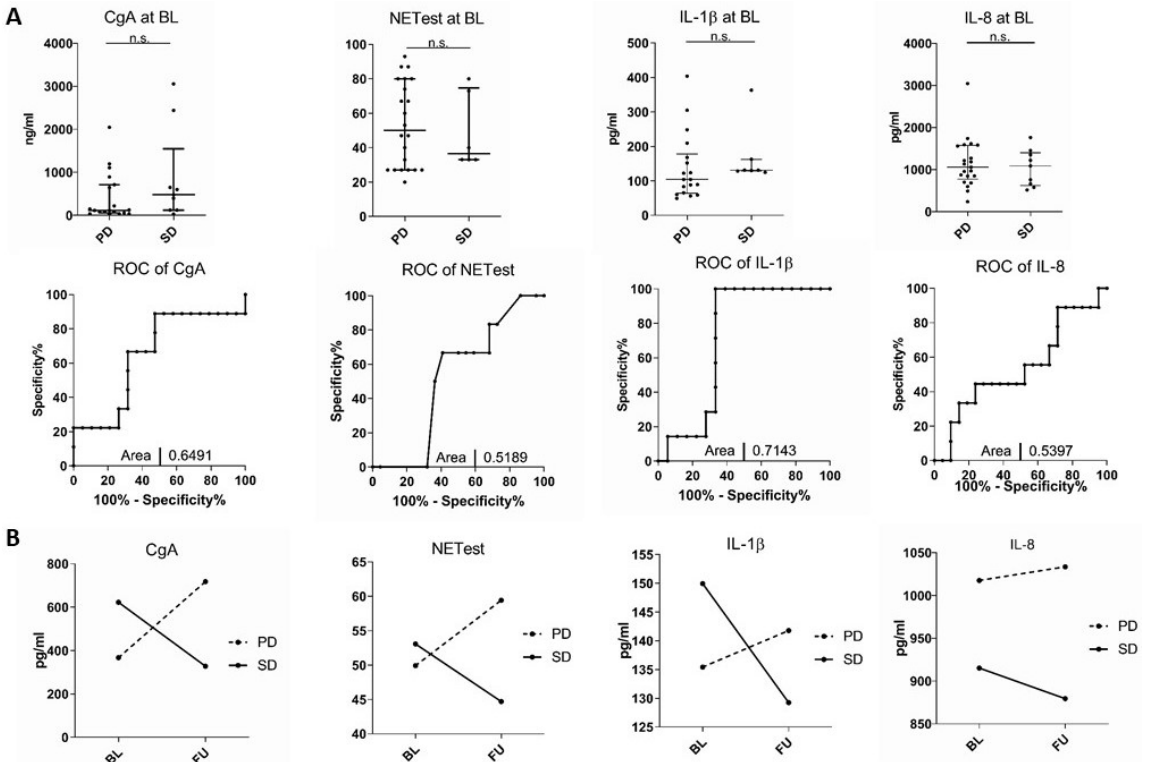
Figure 3. Serum cytokine levels at initial diagnosis may indicate the course of disease. ( A ) Analysis and ROC of serum cytokines between NET patients at the initial time point between progressive disease (PD) and stable disease (SD). ( B ) Time-course cytokine data sorted by disease status at the baseline (BL), initial follow-up (FU), and follow-up (FU) that was observed in the preparation of this study. Shown are the average values of patients with stable/remissive disease (full) and progressive (dotted line) disease. Horizontal bars indicate median and IQR; AUC was automatically calculated using GraphPad Prism.